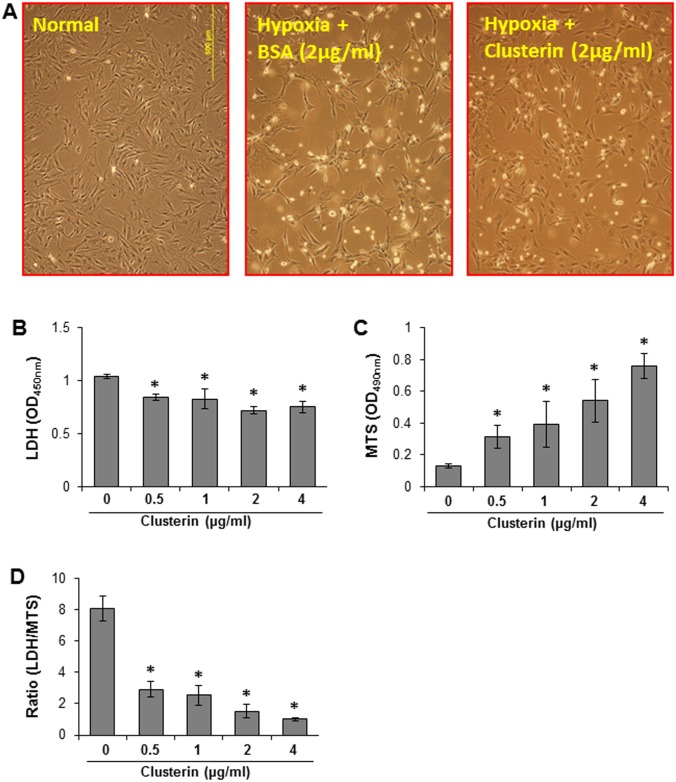
The protective effect of clusterin (0 ~ 4 μg/ml) on MSCs subjected to hypoxia for 72 h.A. Morphological changes of MSCs under different treatments; B. LDH release; C. MSC survival assayed as MTs test; D. Ratio of LDH to MTs.